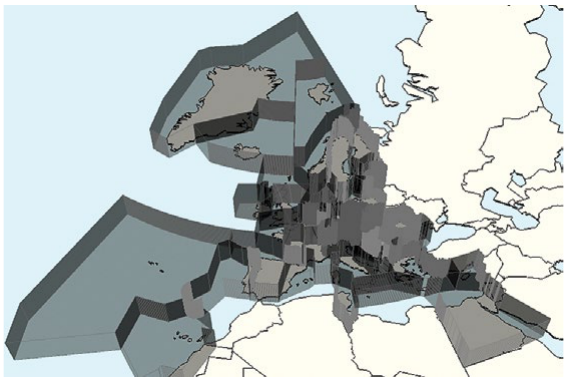
Fig. 6. The analysed airspace